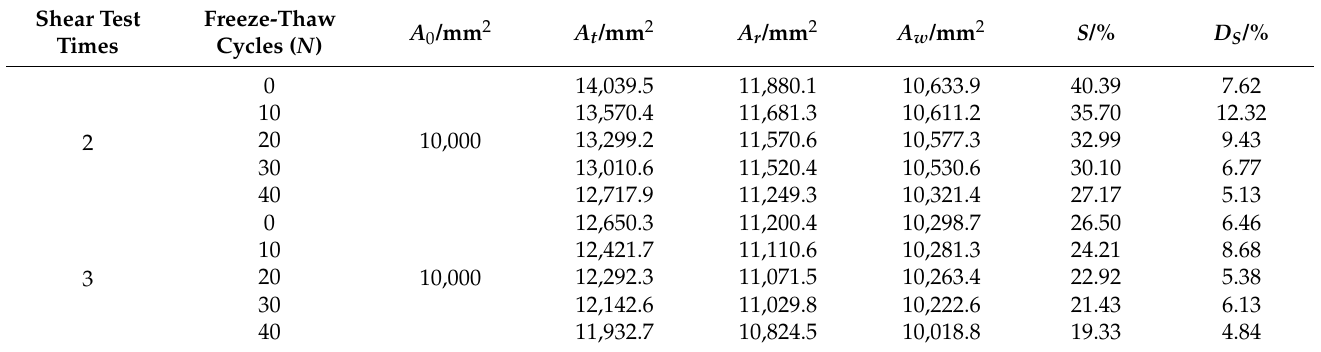
Table 2. Three-dimensional roughness parameters of jointed rock specimens before and after shearing. Shear